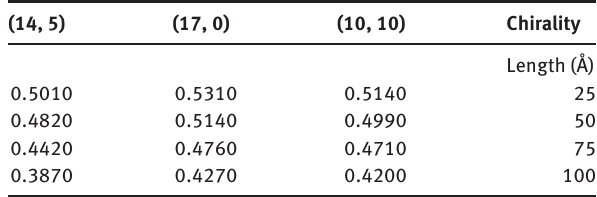
Table 2 Stress intensity factor of RVEs with (10, 10), (17, 0), (14, 5)